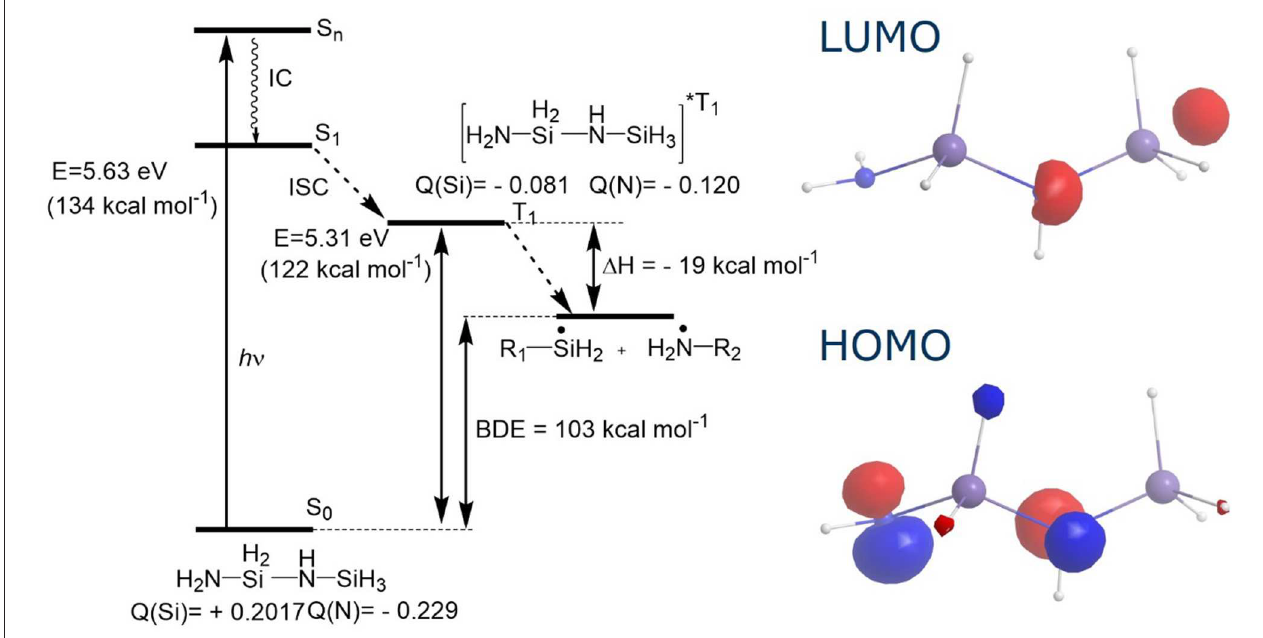
FIGURE 6 | Results on quantum-chemical calculations on the photochemical excitation of model substance H 2 N-SiH 2 -NH-SiH 3 and subsequent bond scission, adapted from Prager et al. (2007).